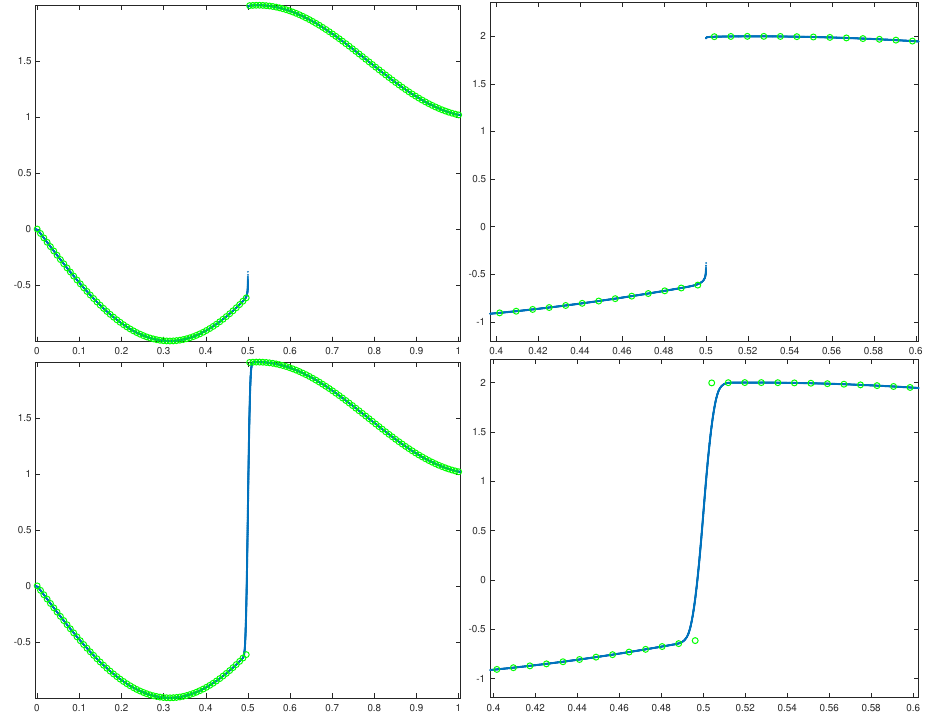
Figure 1. The results obtained for the function in (23) using 10 scales of subdivision. The top left presents the result obtained by the nonlinear version of the three points binary algorithm in (3) and (4). The plot at the top right shows a zoom around the discontinuity. At the bottom of the figure, we can observe the results obtained by the linear algorithm in (2). None of the results show Gibbs oscillations; however, the nonlinear algorithm manages to reduce the diffusion introduced by the linear